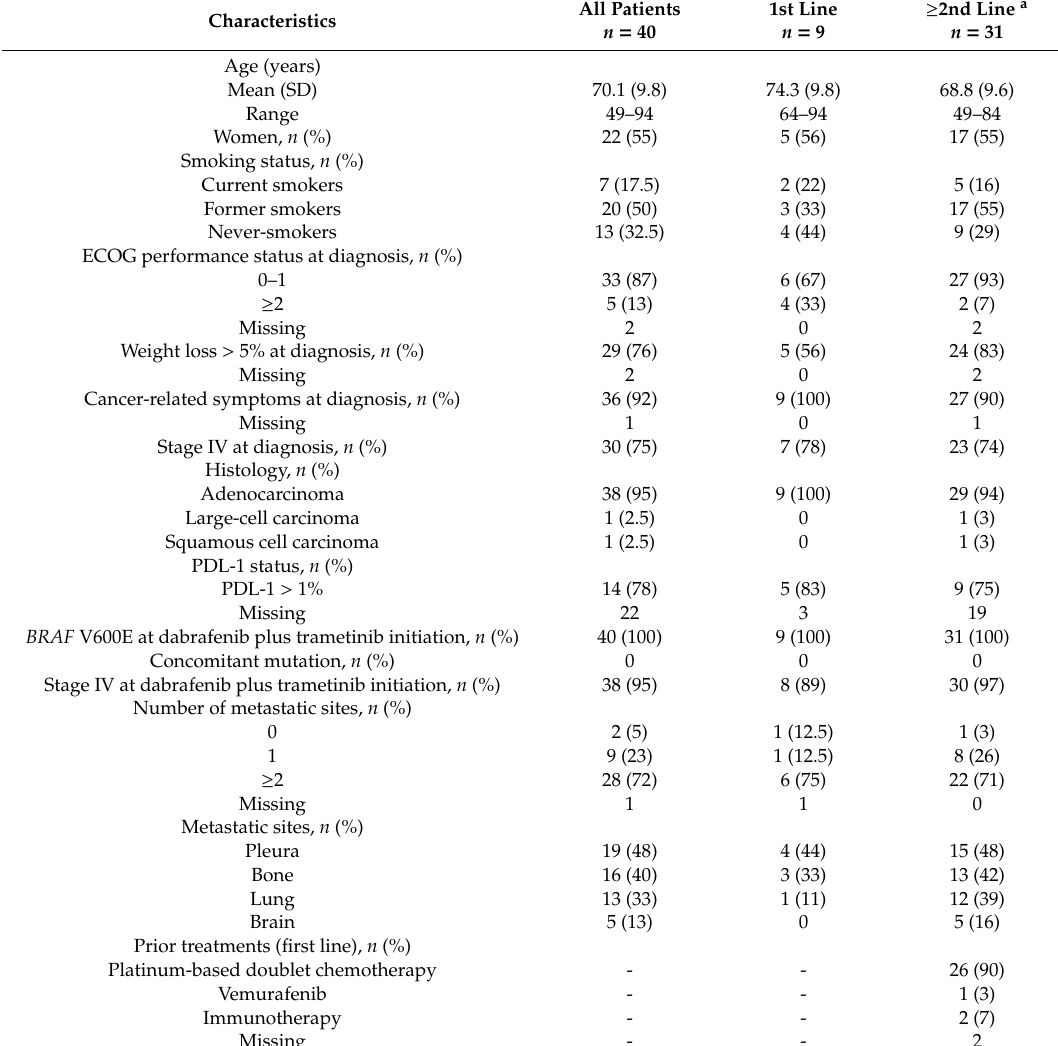
Table 1. Characteristics of